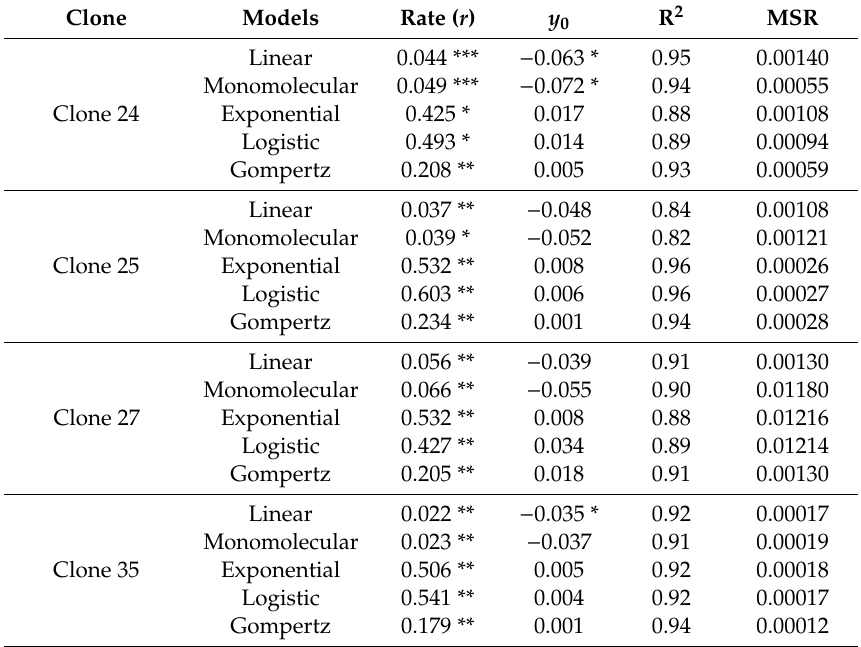
Table 2. Parameters used in the regression analysis of the nonlinear model to compare the fit of the linear and nonlinear models for candeia rust progress